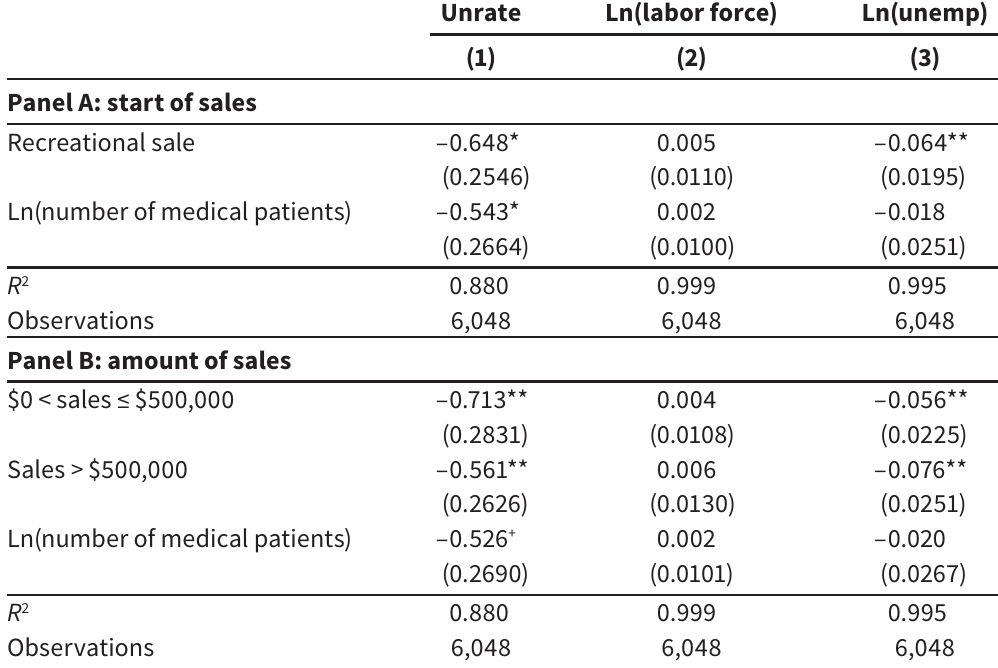
The effect of recreational dispensary entry and sales on the